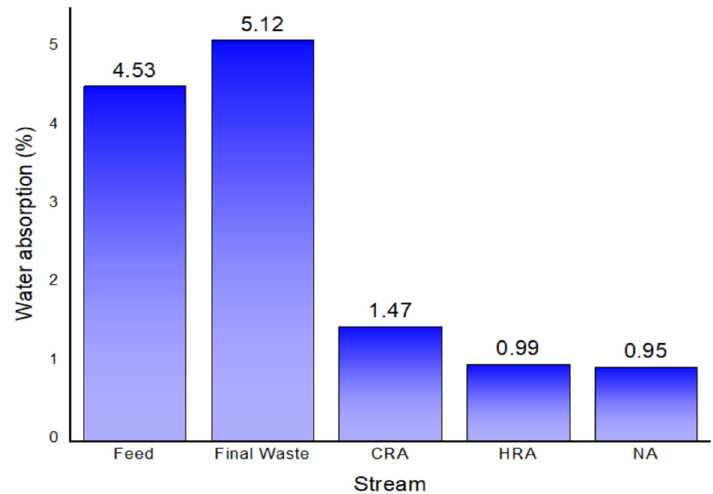
Figure 8. Total water absorption of each aggregate type.